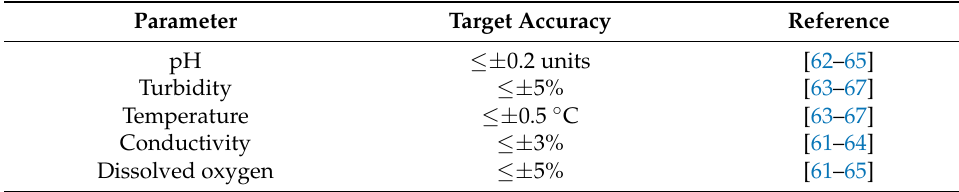
Table 9. Target accuracies for the five high-frequency measurable